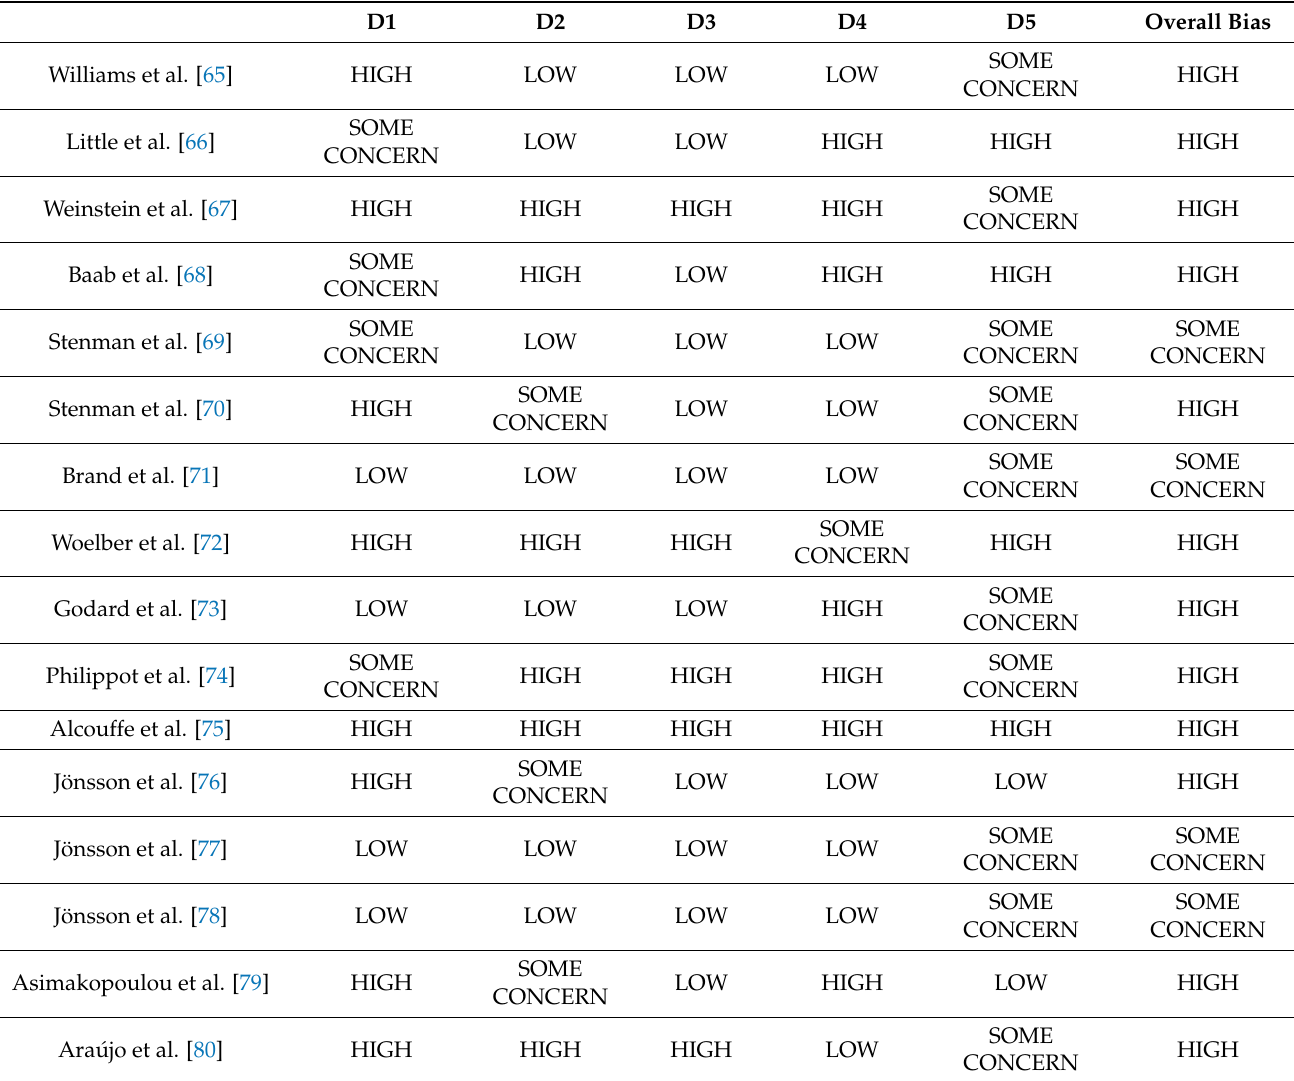
Table 5. Quality assessment of the randomized controlled trials based on Cochrane risk-of-bias tool